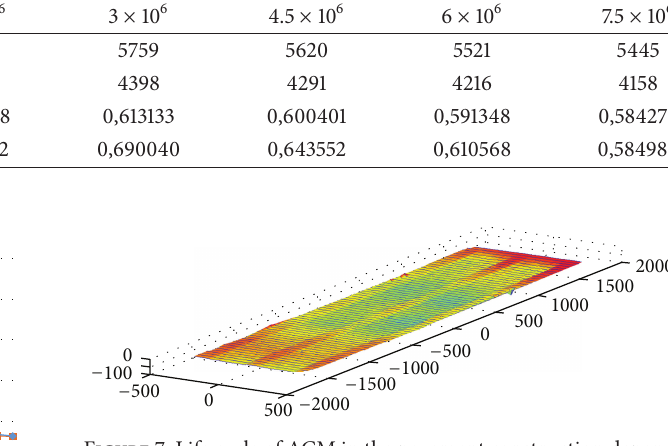
Figure 7: Life cycle of ACM in the pavement construction depend- ing on the number of loading cycles.